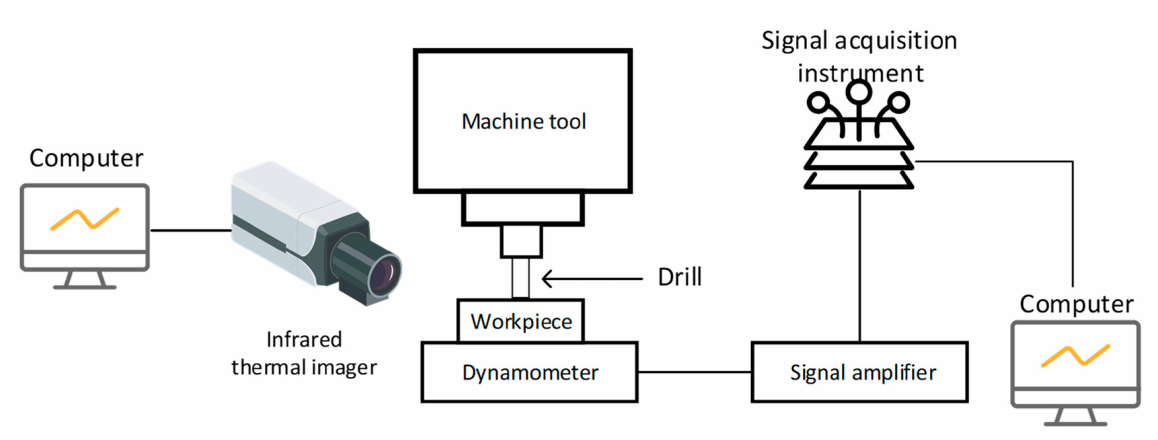
Figure 2. Schematic diagram of drilling